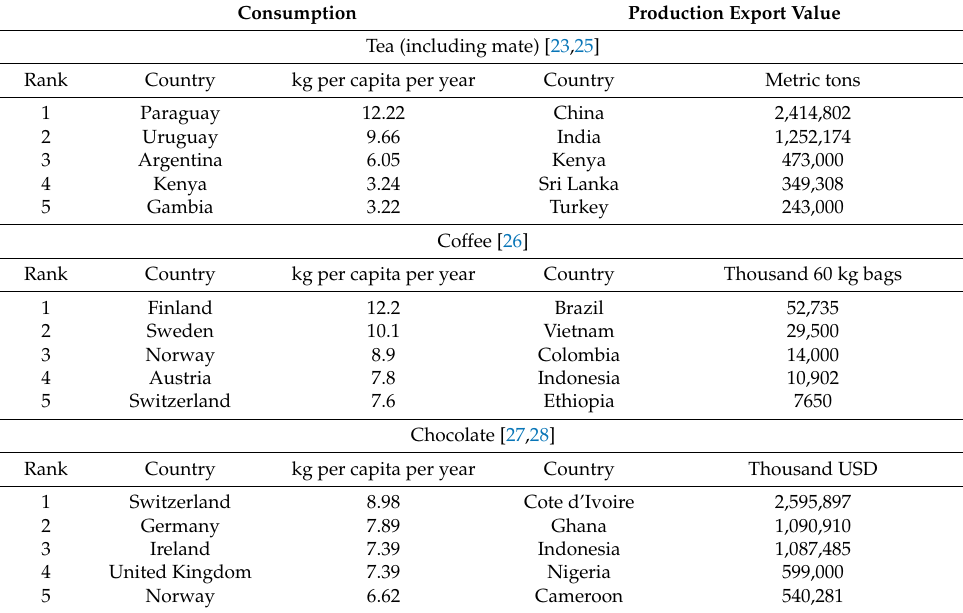
Table 1. Top producing and consuming countries for tea, coffee, chocolate and cocoa, and dried and fresh